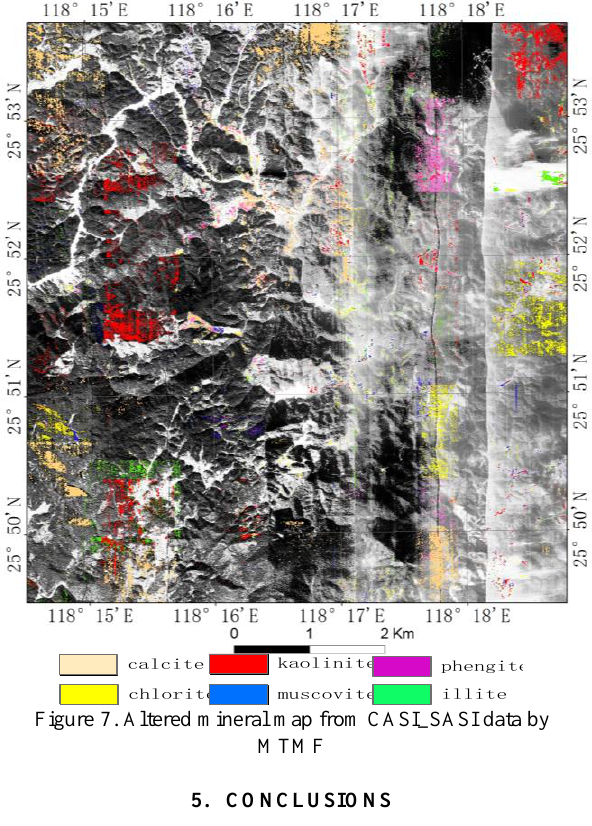
Figure 7. Altered mineral map from CASI_SASI data by